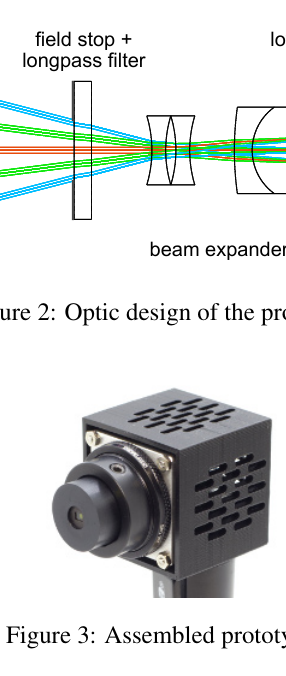
52 . 8 mm. The e ff ective focal length of 0 . 9 mm results in